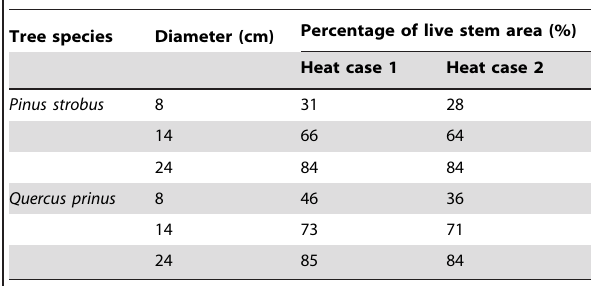
Table 2. Percentage of live stem cross-sectional area (percentage of the tree area that remained intact after the burning experiment) for a Pinus strobus and a Quercus prinus with diameters 8, 14, and 24 cm, for simulation heat case 1 (heating only the front and lee sides of a tree section, along half of the tree’s circumference), and 2 (uniform heating around the full circumference of tree